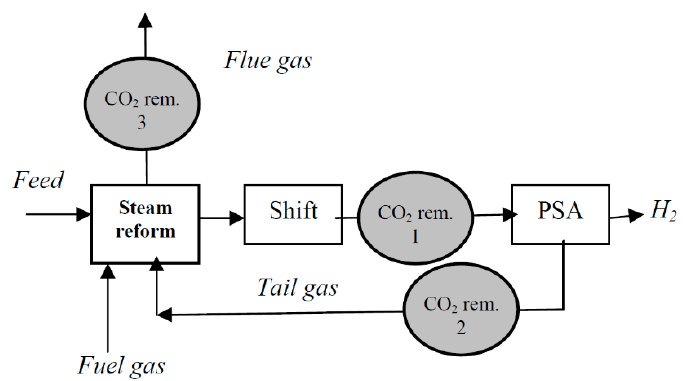
Figure 11. Scheme of a modern steam methane reforming H 2 plant with CO 2 removal [43].